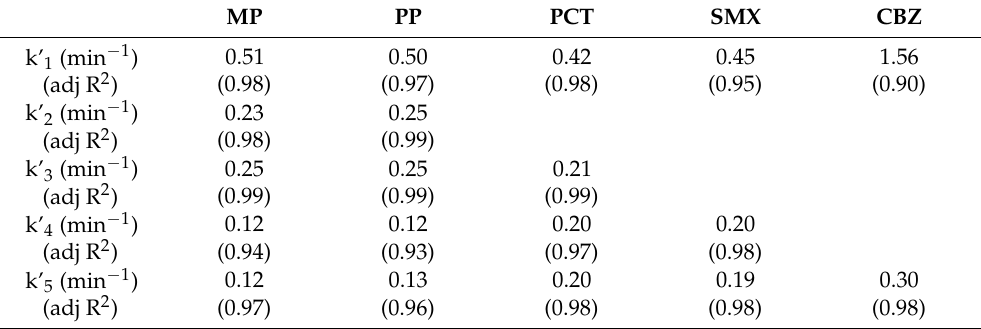
Table 2. Pseudo-first order kinetic rate constants of ozone-treated contaminants in ultrapure water (pH 5.5), individual and in mixture, as function of time. (k’ 1 ) refers to the PPCP individually, whereas k’ 2 , k’ 3 , k’ 4 , and k’ 5 , refer to Mix2, Mix3, Mix4 and Mix5, respectively (k’ a , where a is the number of contaminants in the mixture). Mix2 included MP and PP; Mix3 included MP, PP and PCT; Mix4 included MP, PP, PCT and SMX; and Mix5 included MP, PP, PCT, SMX and CBZ at 1 mg L − 1 each. The corresponding adjusted coefficients of determination (adj R 2 ) are also presented. MP PP